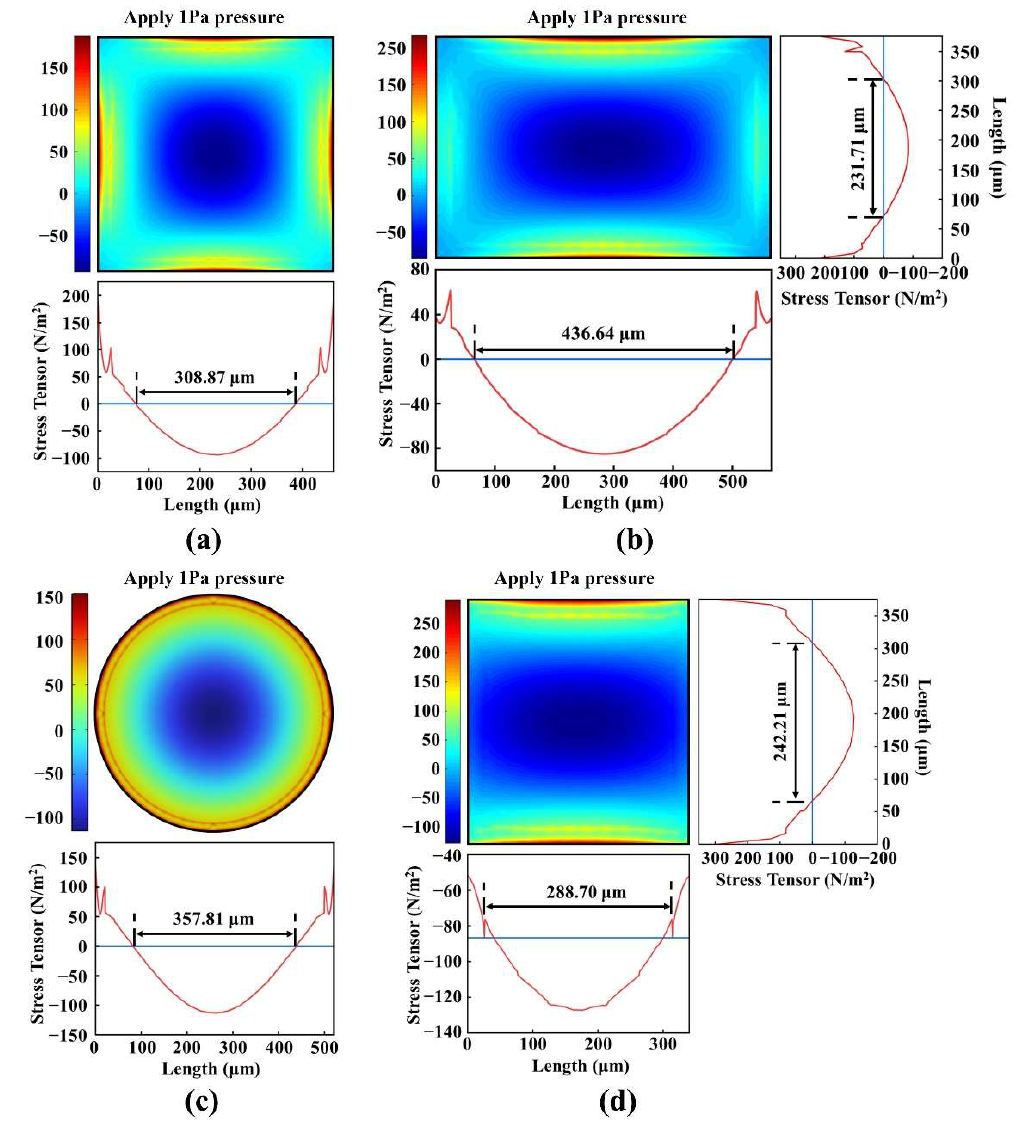
Figure 3. The sum stress distribution of σ xx and σ yy in the PZT piezoelectric layer of ( a ) square diaphragm; ( b ) rectangular diaphragm; ( c ) circular diaphragm; ( d ) I-shaped diaphragm.